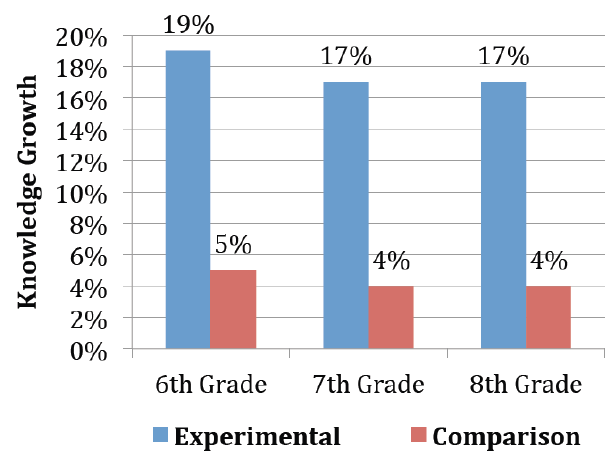
1. Science of Healthful Living: Year 2 Preliminary Data from the Cardio Fitness Club Knowledge Test Comparison (% correct gain) between Experimental and Comparison Schools by